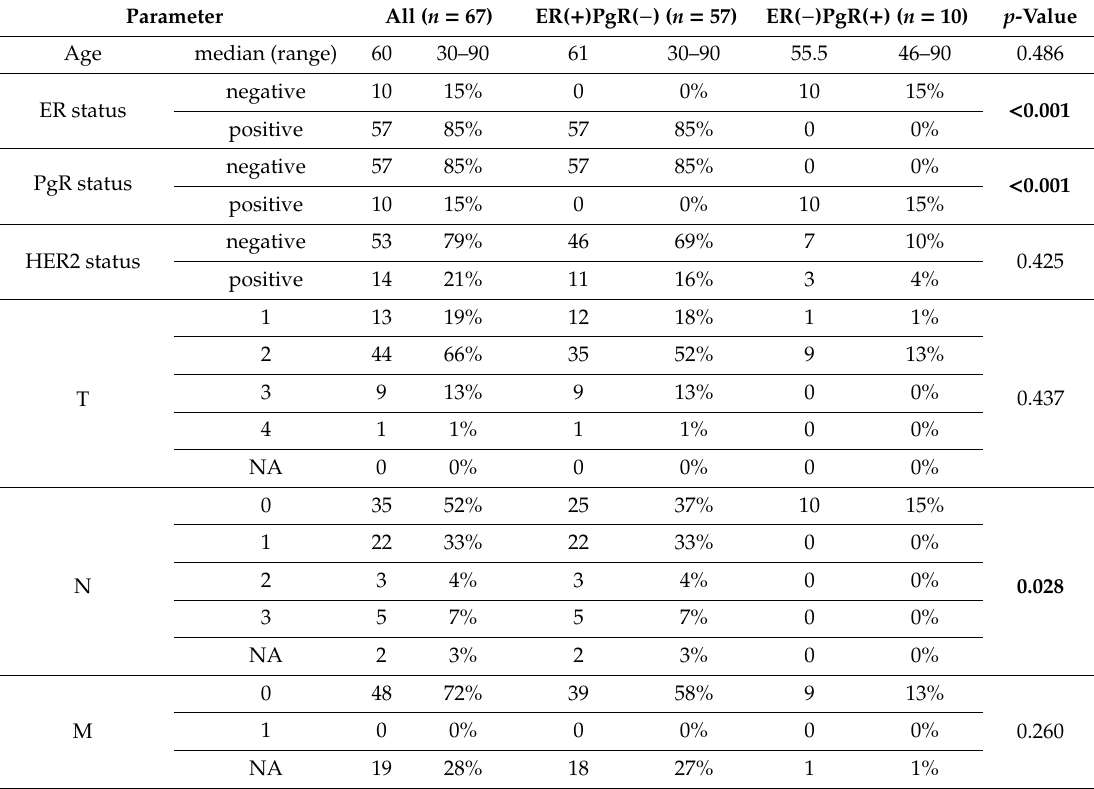
Table 2. Clinicopathological characteristics of patients with single hormone receptor-positive breast tumors in a TCGA breast invasive carcinoma cohort; di ff erences estimated with t -test (age, Ki67, tumor size) or Fisher’s Exact test (ER status, PgR status, HER2 status, T, N, M); significant results ( p -value < 0.05) are in